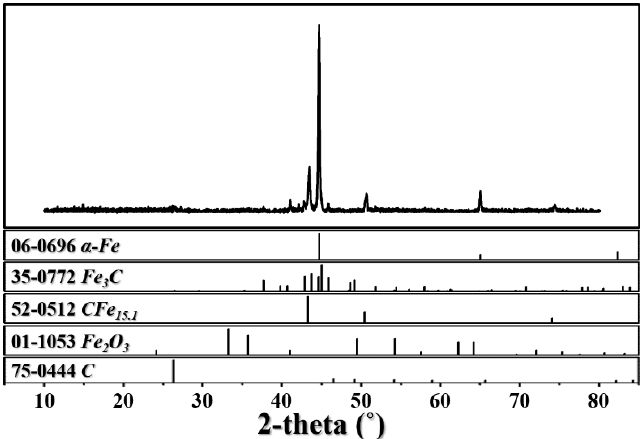
Figure 2. XRD curve of magnetic carbon foam.